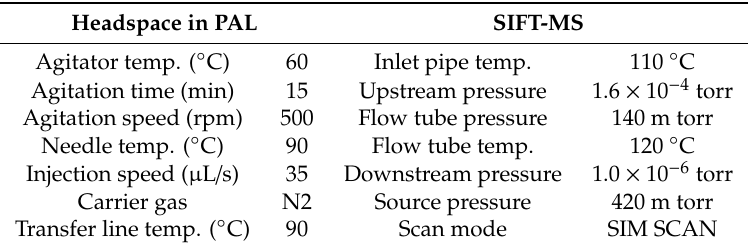
Table 1. Operating conditions of headspace and direct mass